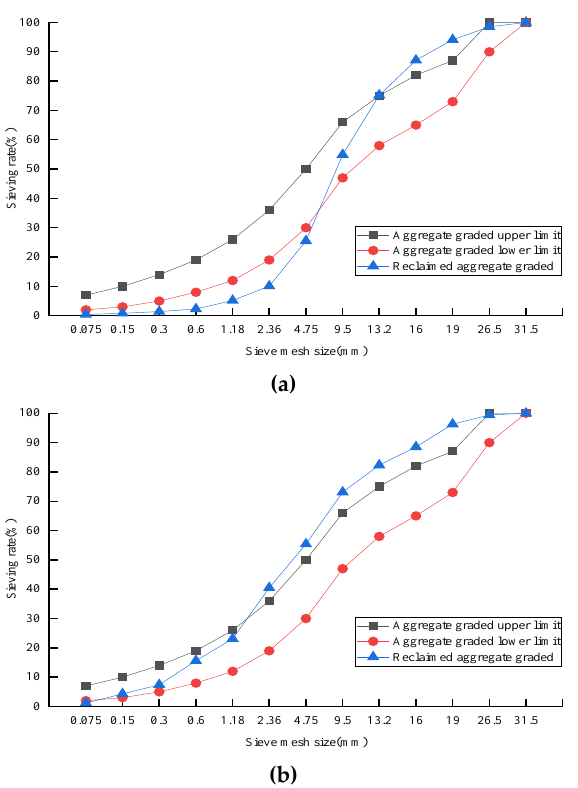
Figure 7. Reclaimed asphalt sieve analysis: ( a ) untreated RAP mixture; ( b ) extracted RAP mixture.